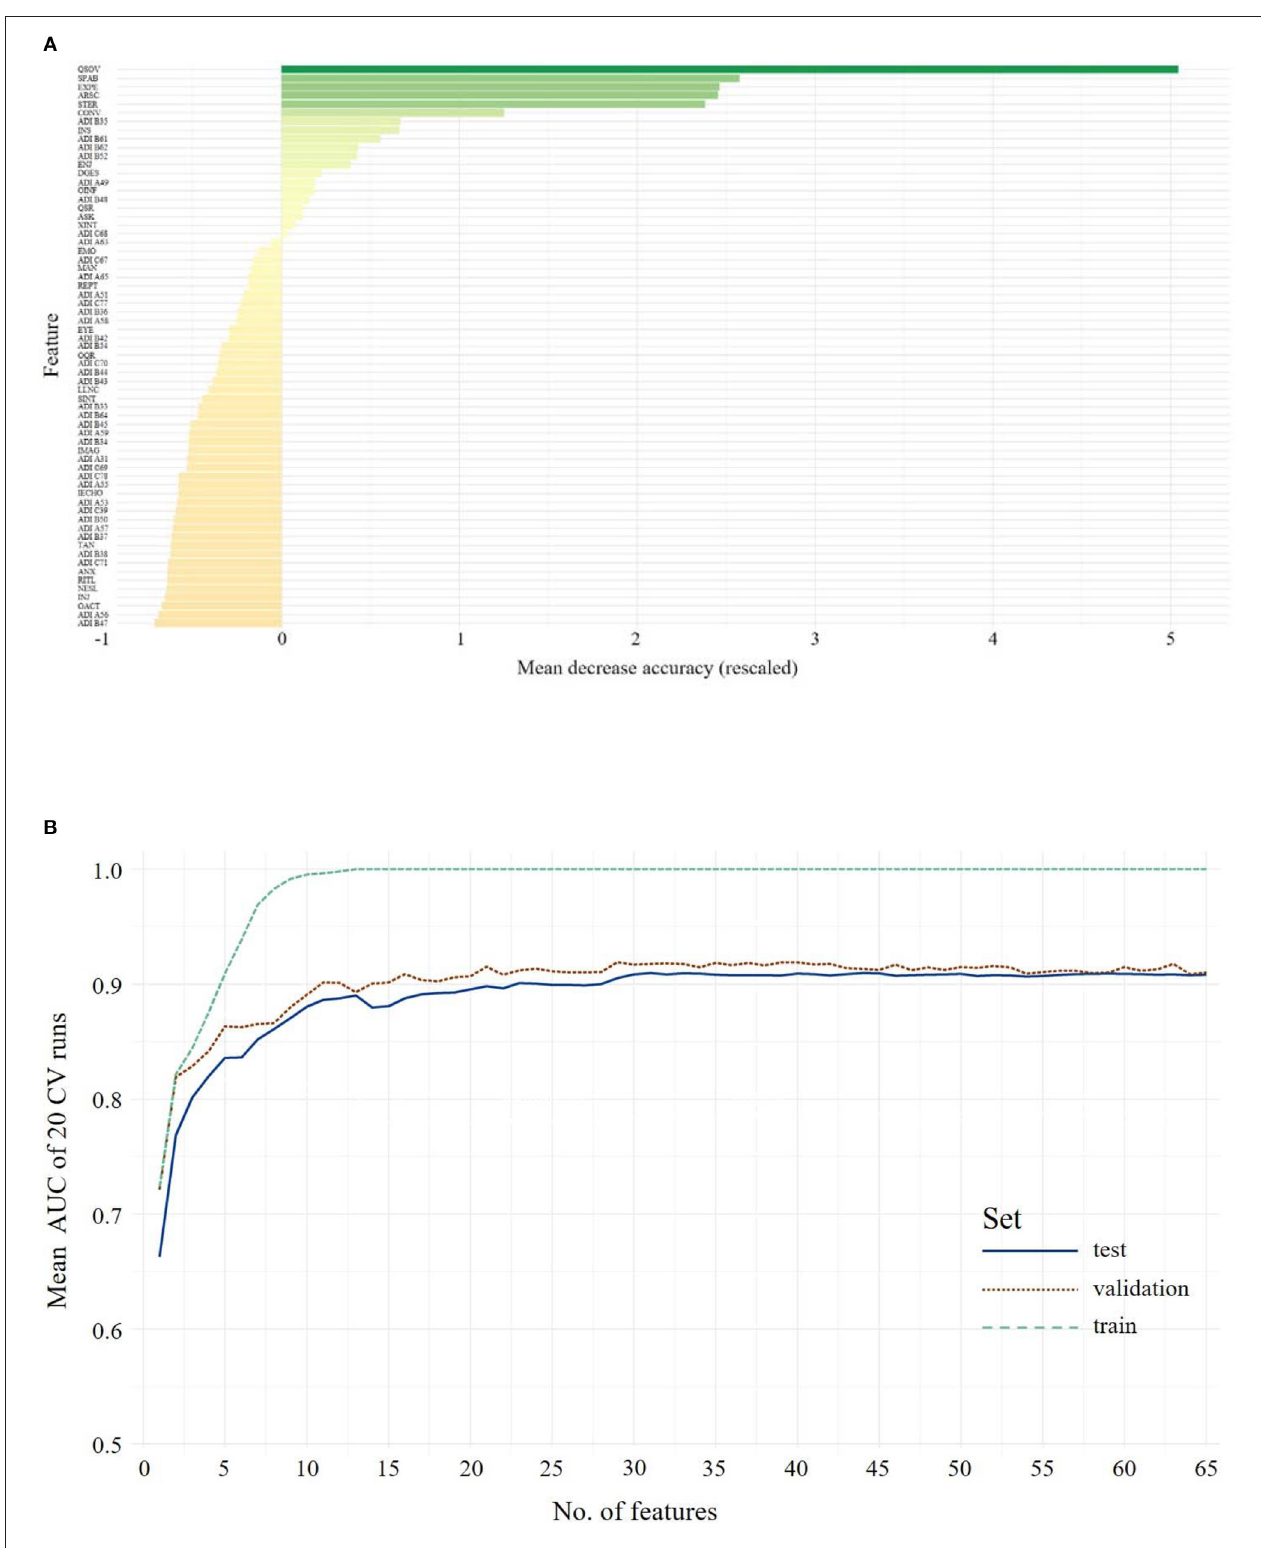
FIGURE 1 | The upper panel shows the overall ranking of feature importance for all features from ADOS and ADI-R data combined for Children/Younger Adolescents (A) . The figure depicts the ADOS and ADI items on the y-axis and on the x-axis its corresponding importance score, measured in mean decrease in accuracy. The lower panel (B) shows the mean AUC plotted against the number of model features from ADOS and ADI-R combined during model building (training, testing and validation of the classifiers) for Children/Younger Adolescents . A list of all included features and their abbreviations can be found in Supplementary Table 3